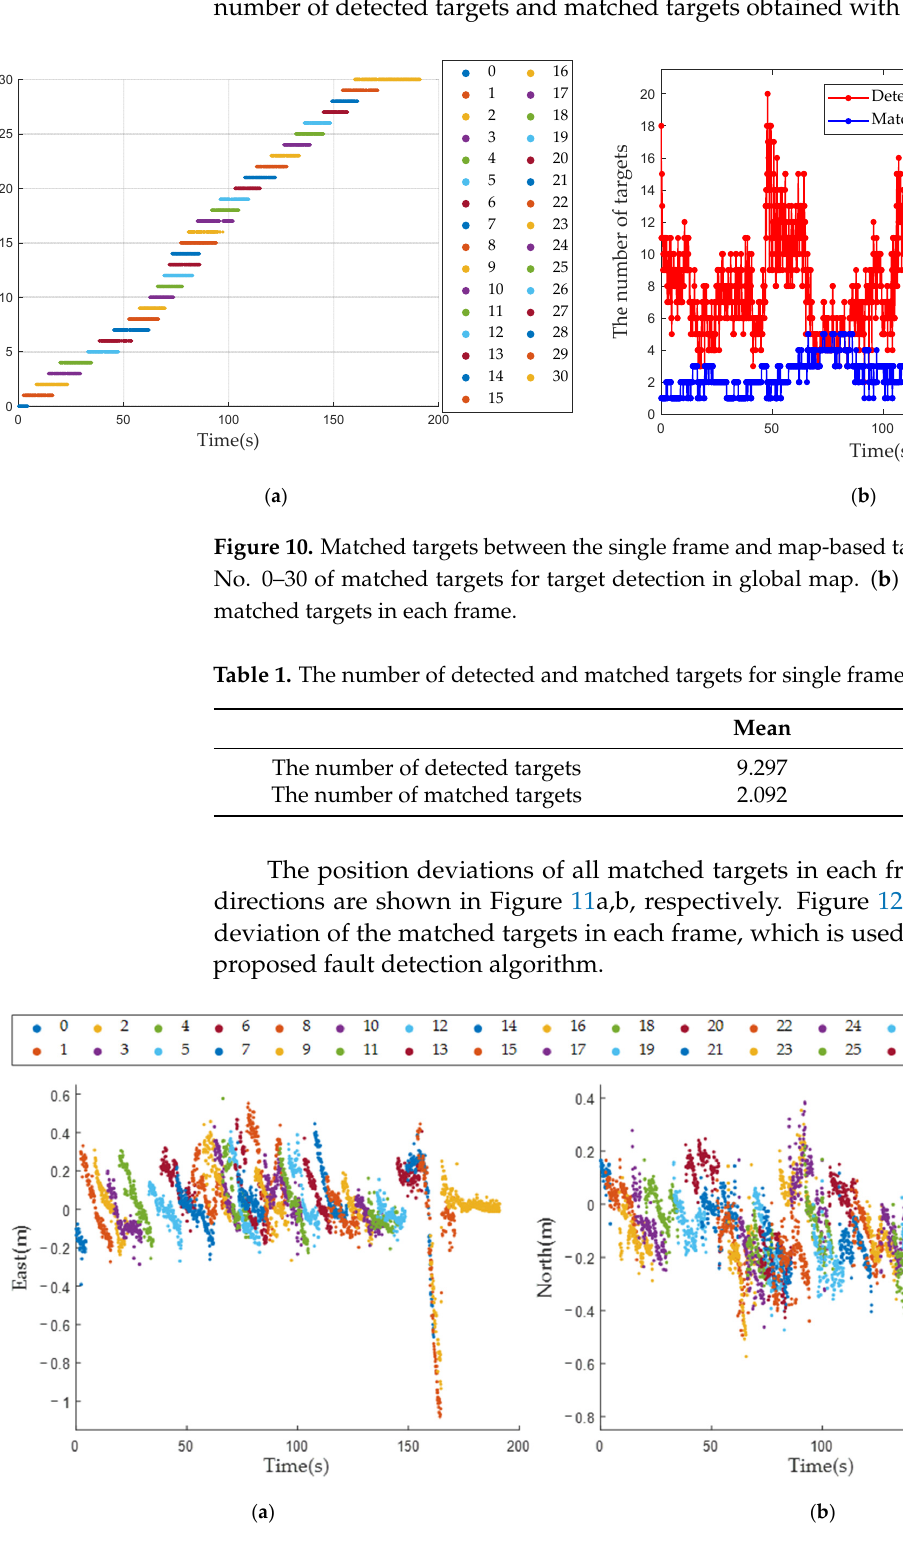
Figure 9. Single frame point cloud target detection. ( a ) The 645th frame and No. 8 – 10 targets in Figure 8. ( b ) The 1023rd frame and No. 17 – 18 targets in Figure 8.